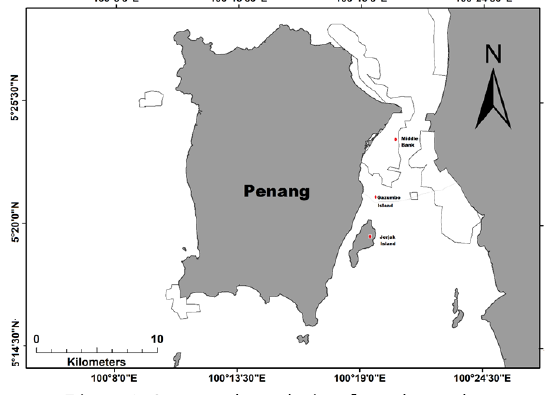
Figure 1. Seagrass boundaries along the study area.